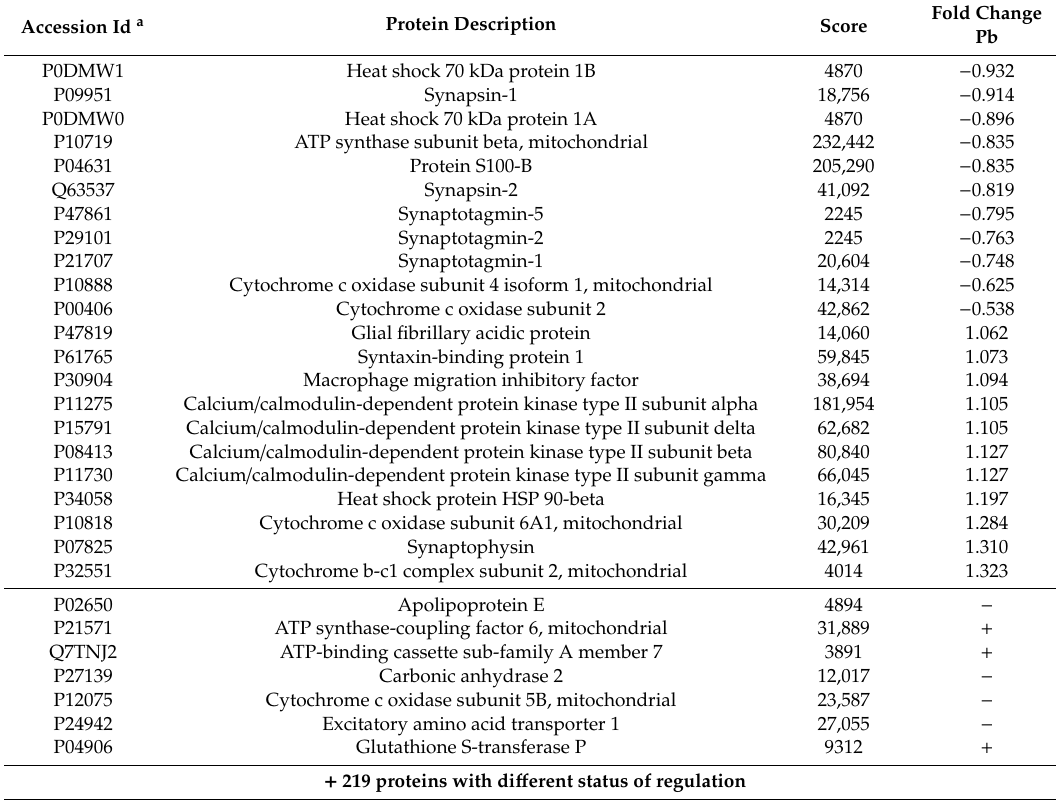
Table 1. Identified proteins with expression significantly altered in the hippocampus of rats of exposed group (Pb) vs.